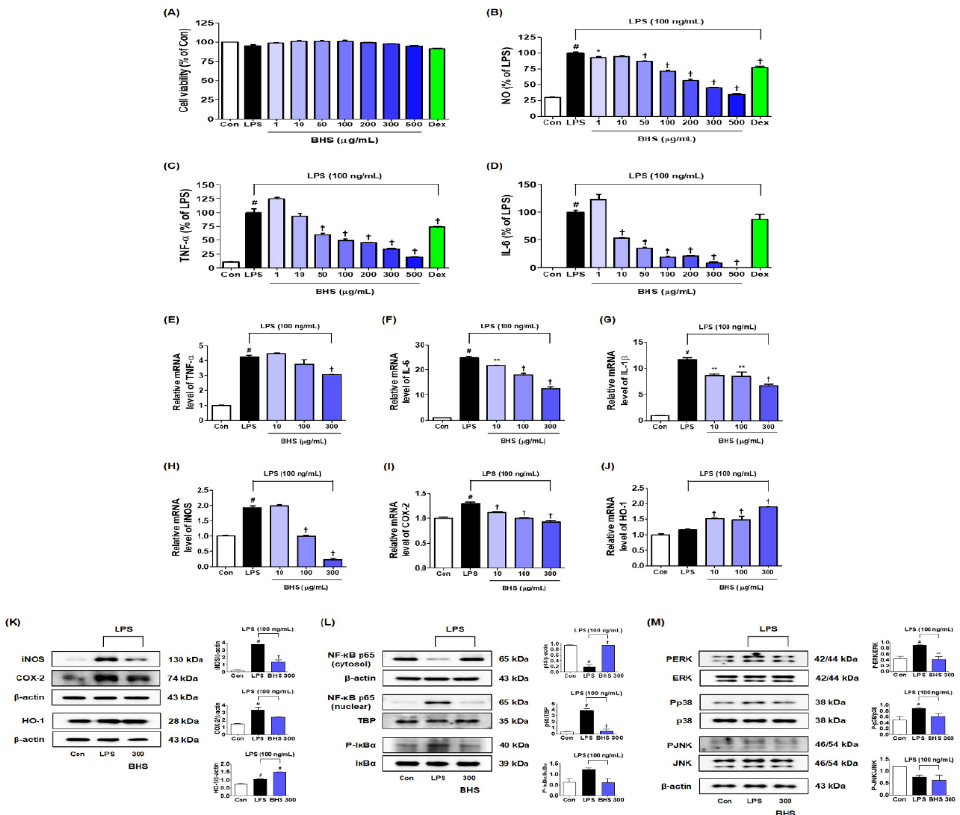
Figure 7. Effects of BHS on the inflammatory response of LPS-stimulated BV2 microglial cells: ( A )